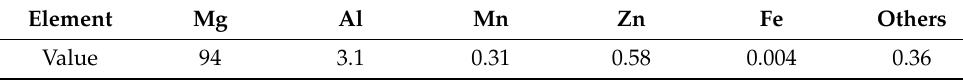
Table 1. Chemical composition of AZ31 magnesium alloy (mass %).